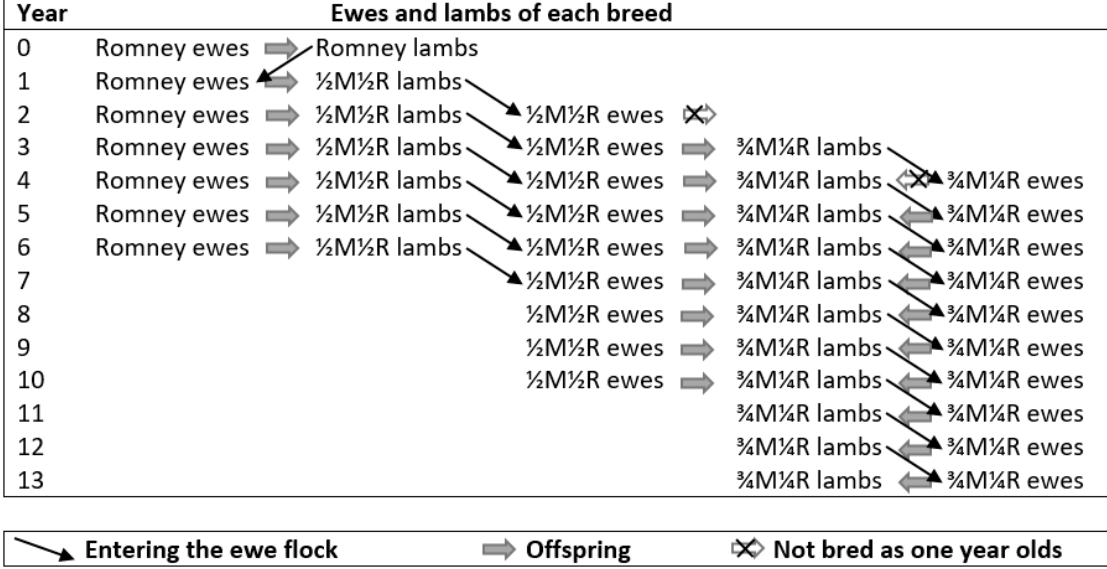
Figure 1. Simplified diagram of sheep breeds on-farm during a whole flock grading up breed transition from Romney to second cross ¾Merino¼Romney, showing production of Romney and crossbred Merino–Romney lambs and also lambs entering ewe flocks (ewes aged one to seven years old) each year from the start of breed transition. Where ½M½R lambs and ewes were first cross ½Merino½Romney sheep. Reprinted with permission from ref. [5]. 2021 Elsevier.